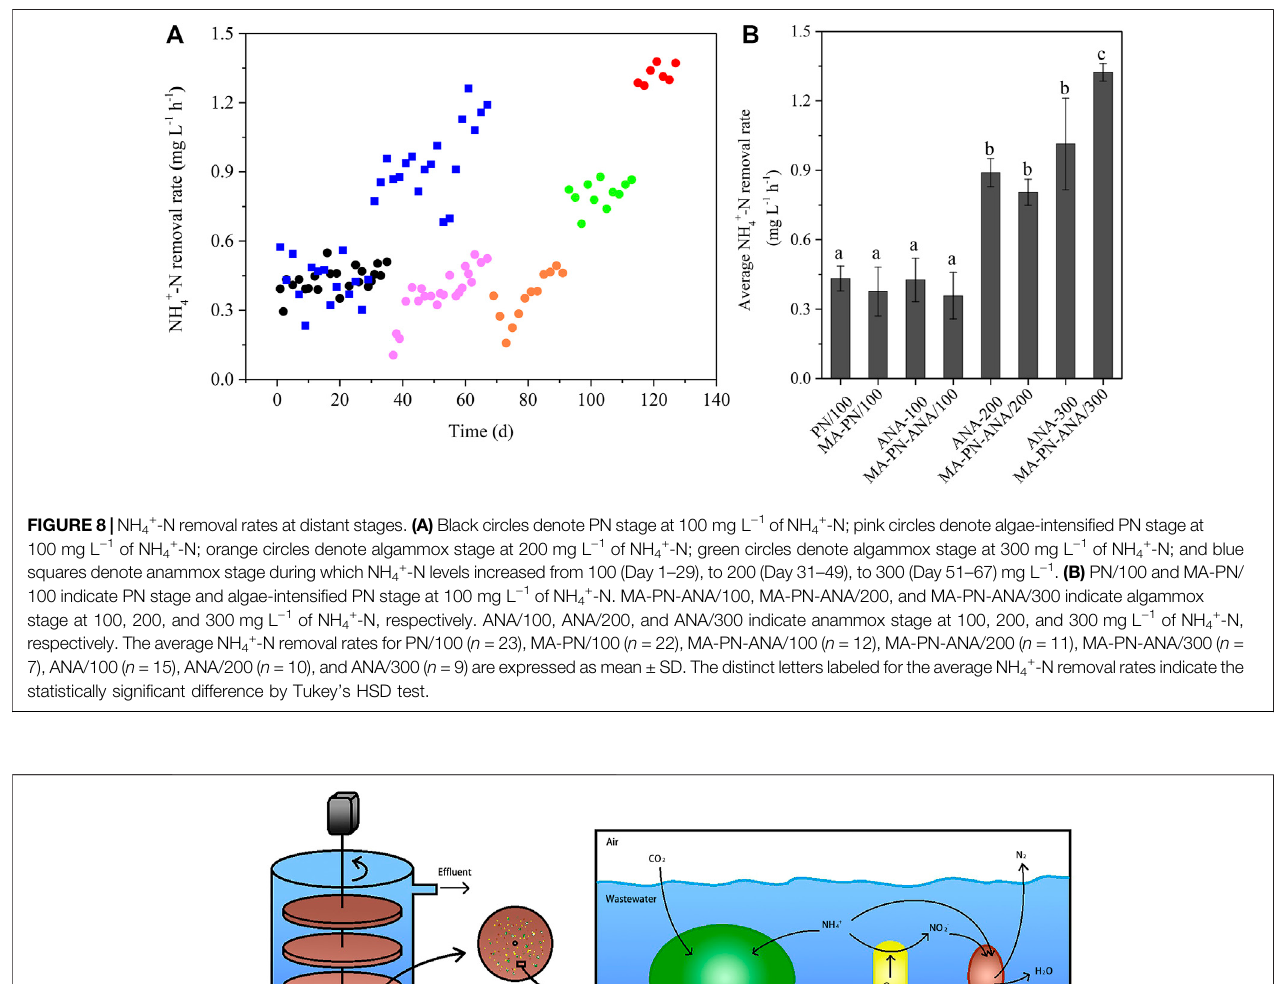
Frontiers in Bioengineering and Biotechnology |